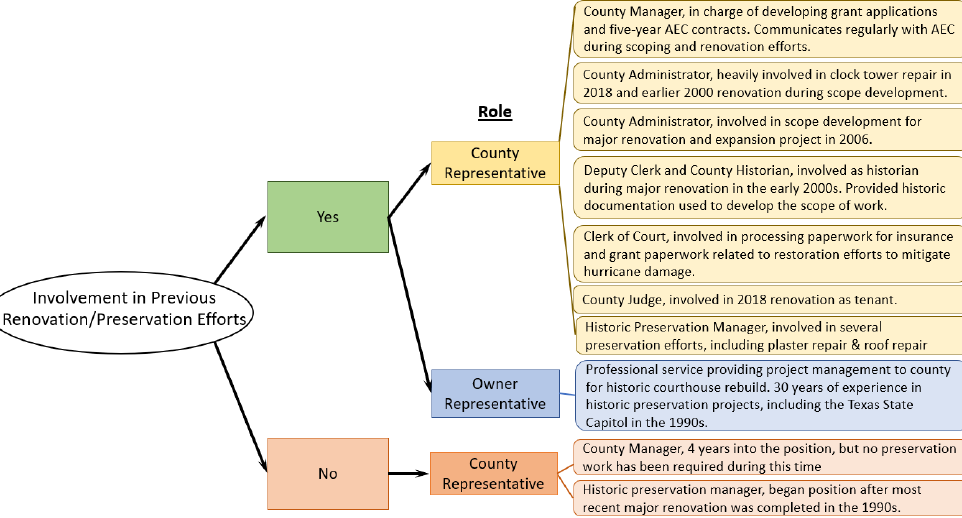
Figure 14. Results to interview question #4: data management techniques. All ten courthouses have some form of data management for general conservation, renovation, or restoration data. The management method is limited to maintaining paper